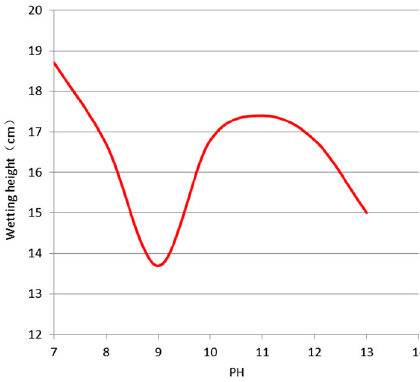
Fig. 2 Curve of pulverized coal’s average wetting height varying with the change of pH values in